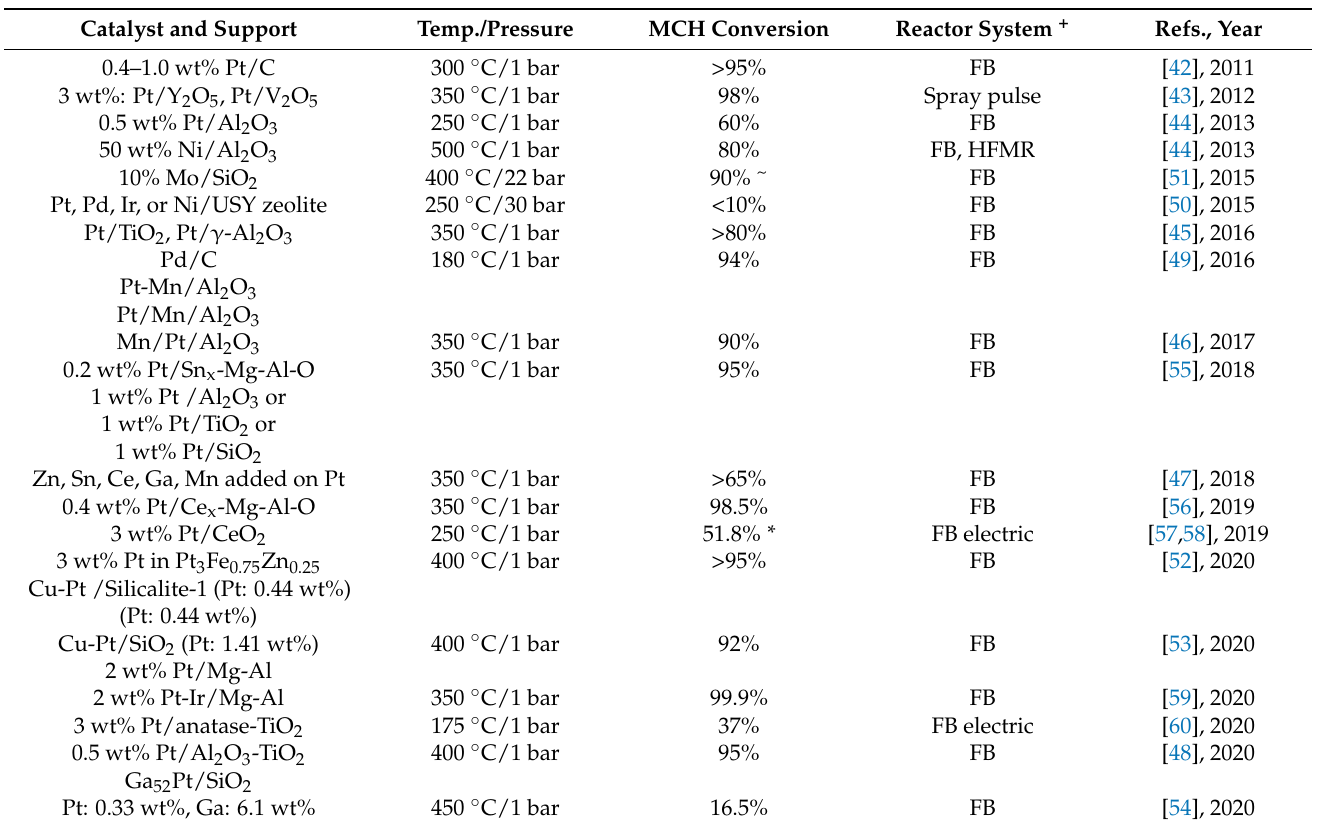
Table 2. Reported catalysts for MCH dehydrogenation post